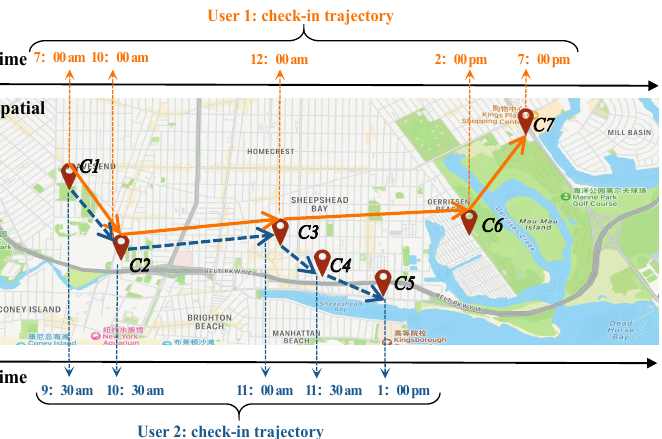
Figure 1. Illustration of spatio-temporal unequal interval relationship existing in users’ check-in